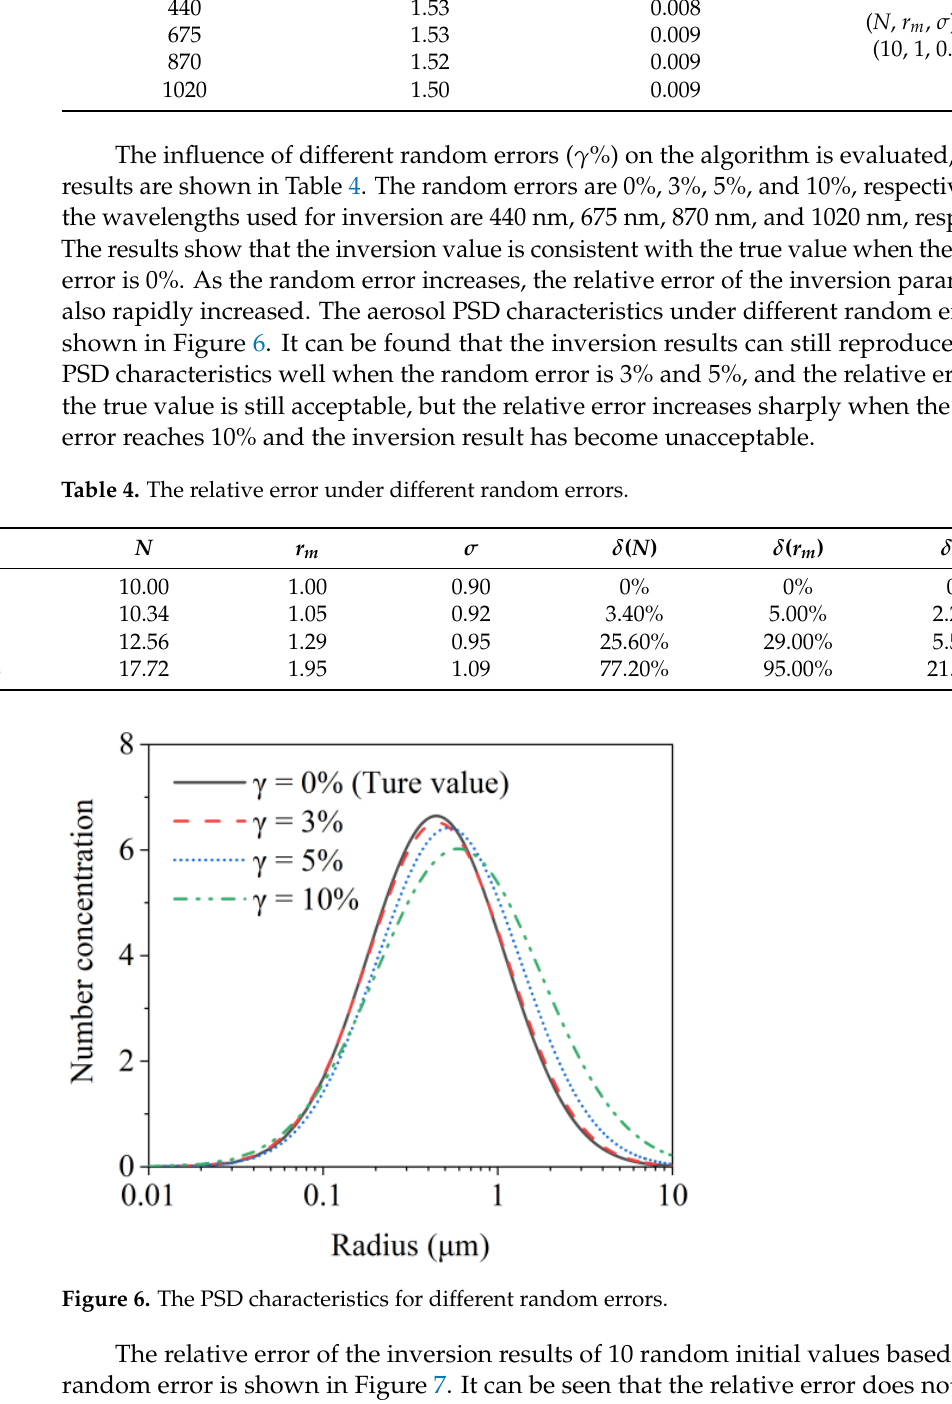
Figure 7. The relative error for different random initial values. The effects of the number of samples on the inversion results are also compared in this paper. The comparison is necessary, because the measurement results of sun photom- eters in different wavelengths are inevitably noisy and distorted, and severe noise may cause data in a certain wavelength to be unavailable. The results are shown in Table 5 and Figure 8. “Without 440 nm” means that 440 nm is discarded among the four inversion wavelengths of 440 nm, 675 nm, 870 nm, and 1020 nm and uses the remaining three wave- lengths for inversion. The other “Without” labels are similar to “Without 440 nm”. “With 250 nm” means that four wavelengths of 250 nm, 675 nm, 870 nm, and 1020 nm are used for inversion. “All wavelengths” means that all five wavelengths are used for inversion. The results show that the inversion results of the two cases such as “All wavelengths” and “With 250 nm” are consistent with the true values, and the relative error is almost 0%. The